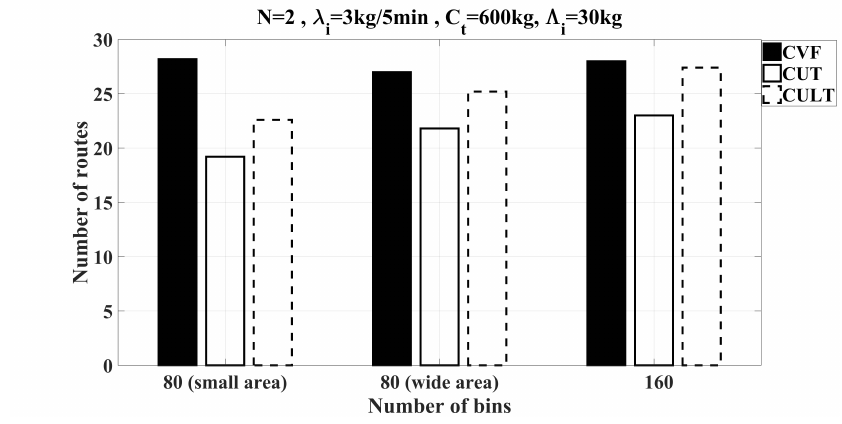
Figure 22. Number of routes: bin count as the number of bins